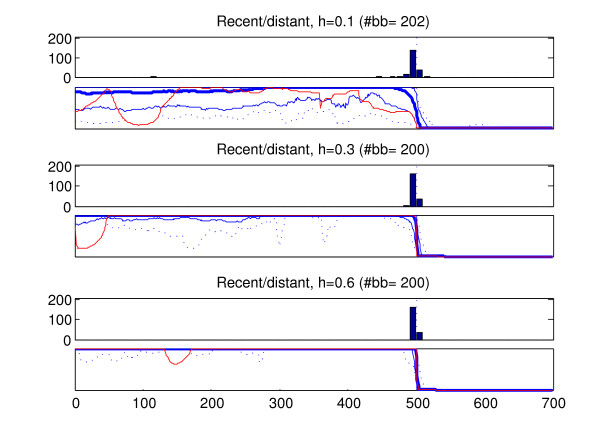
Results, recent recombination event with a distant relative. Summary of results for 200 strains which have undergone recent recombination with strains to which they are distantly related. Sites 501–700 have been obtained through recombination. The results are shown for three different heights of evolutionary trees (0.1, 0.3, 0.6, measured as the expected number of substitutions from the root to a leaf in a tree). For each tree height, two plots are shown: the upper plot shows a histogram of the inferred breakpoint locations, the lower plot shows five percentiles for the probabilities of the left-side origin given by the inferred marginal probability profiles (dotted line: 0th and 100th percentile, thin solid blue line: 5th and 95th percentile, thick blue line: 50th percentile). The solid red line shows one particular marginal probability profile. This profile is the one deviating most (in mean squared error sense) from the 'correct' profile, which in this particular case would assign probability unity for the left-side origin in sites 1–500 and probability 0 in sites 501–700. The total numbers of inferred breakpoints for different tree heights are shown in the titles of the respective plots (#bb). The x-axis coordinates shown below the lowest plot specify the location along the gene in any of the plots.